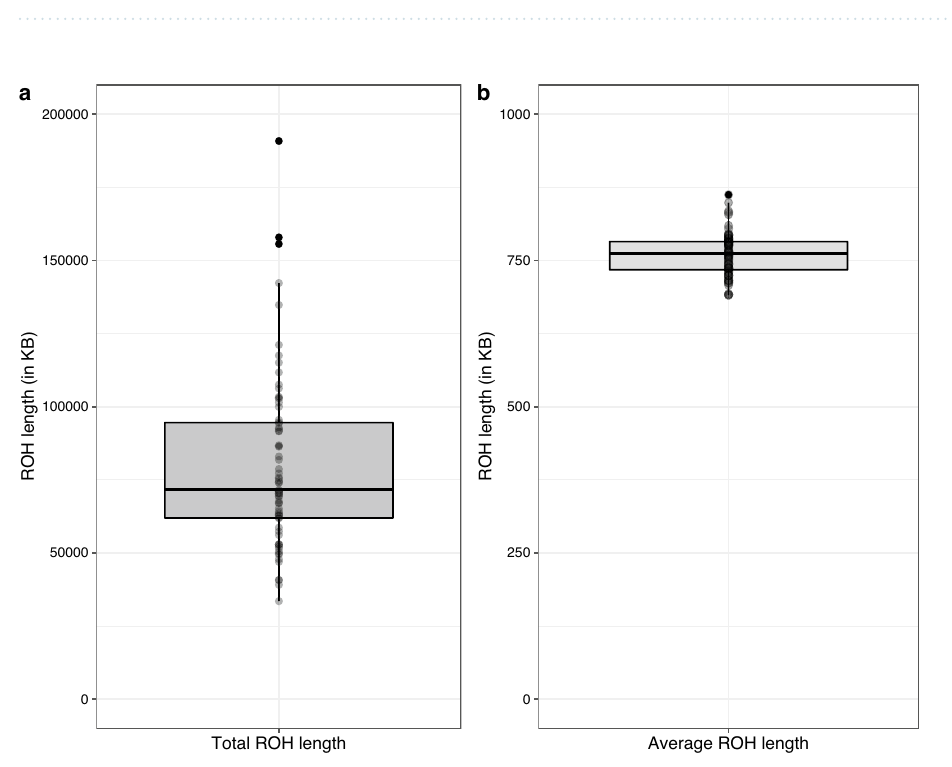
Table 1. Summary of relationship category assignment (RCA) for African wild dogs ( Lycaon pictus ) from Kruger National Park (KNP), South Africa obtained from single nucleotide polymorphisms (SNP) allelic profiles using PLINK v1.90. x Z 0 , average probability to share zero identity-by-descent (IBD) alleles; x Z 1 , average probability to share one IBD allele; x Z 2 , average probability to share two IBD alleles; and x PI-HAT, average relatedness measure.